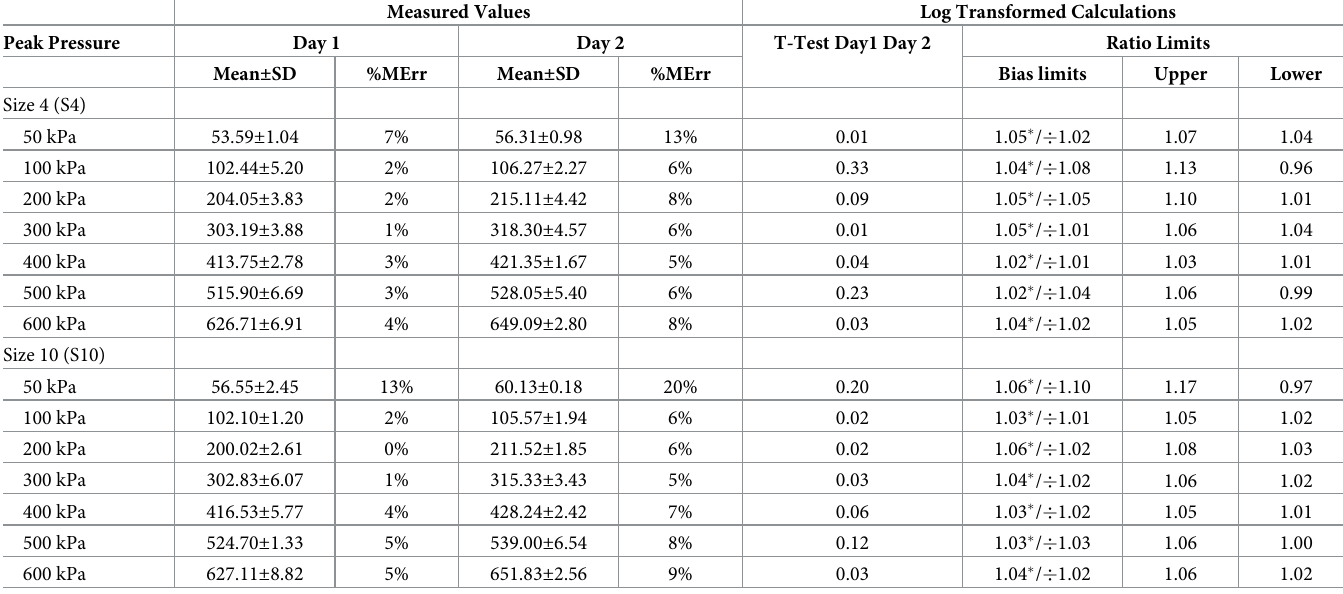
Table 1. Average peak pressure at each target pressure at 2 seconds for Day 1 and Day 2 the differences, and the “ratio limits of agreement” alongside the t-test between the measures of day 1 and 2. Measured Values Log Transformed Calculations